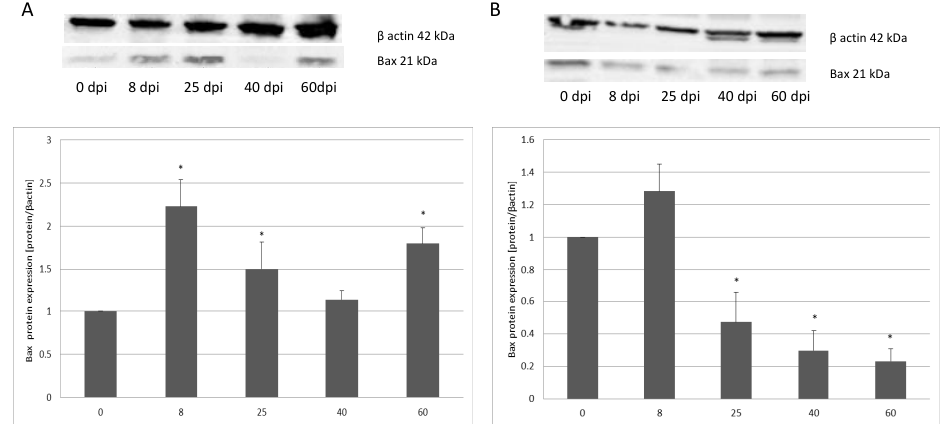
to the 0 dpi group (Figure 3).